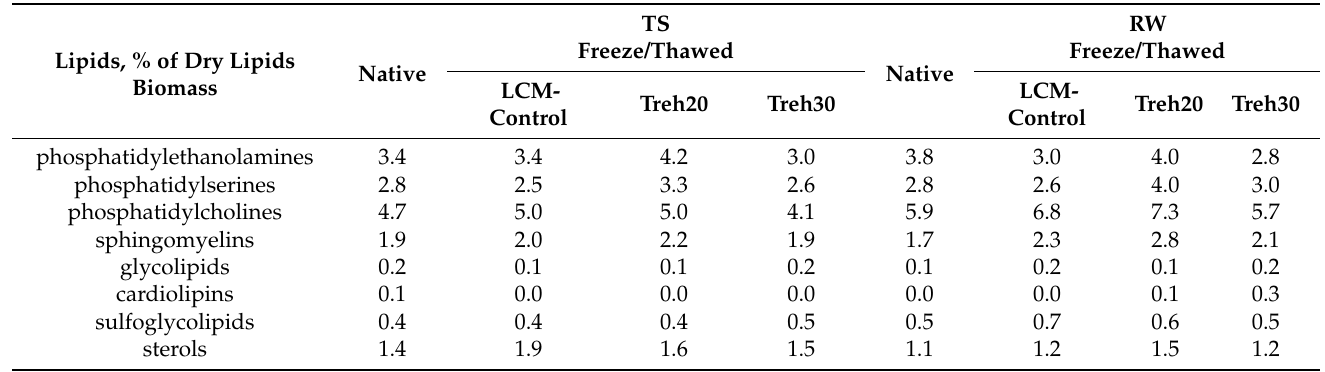
Table 2. The lipid composition of spermatozoa membranes of native and frozen/thawed rooster